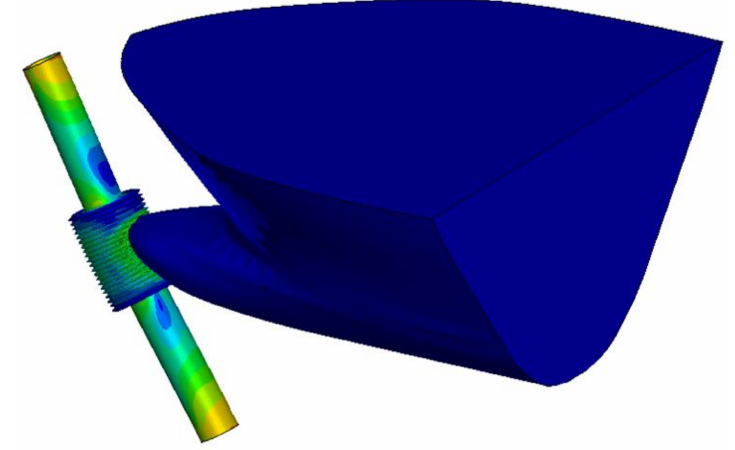
Figure 11. Deformation of the pile leg under ship